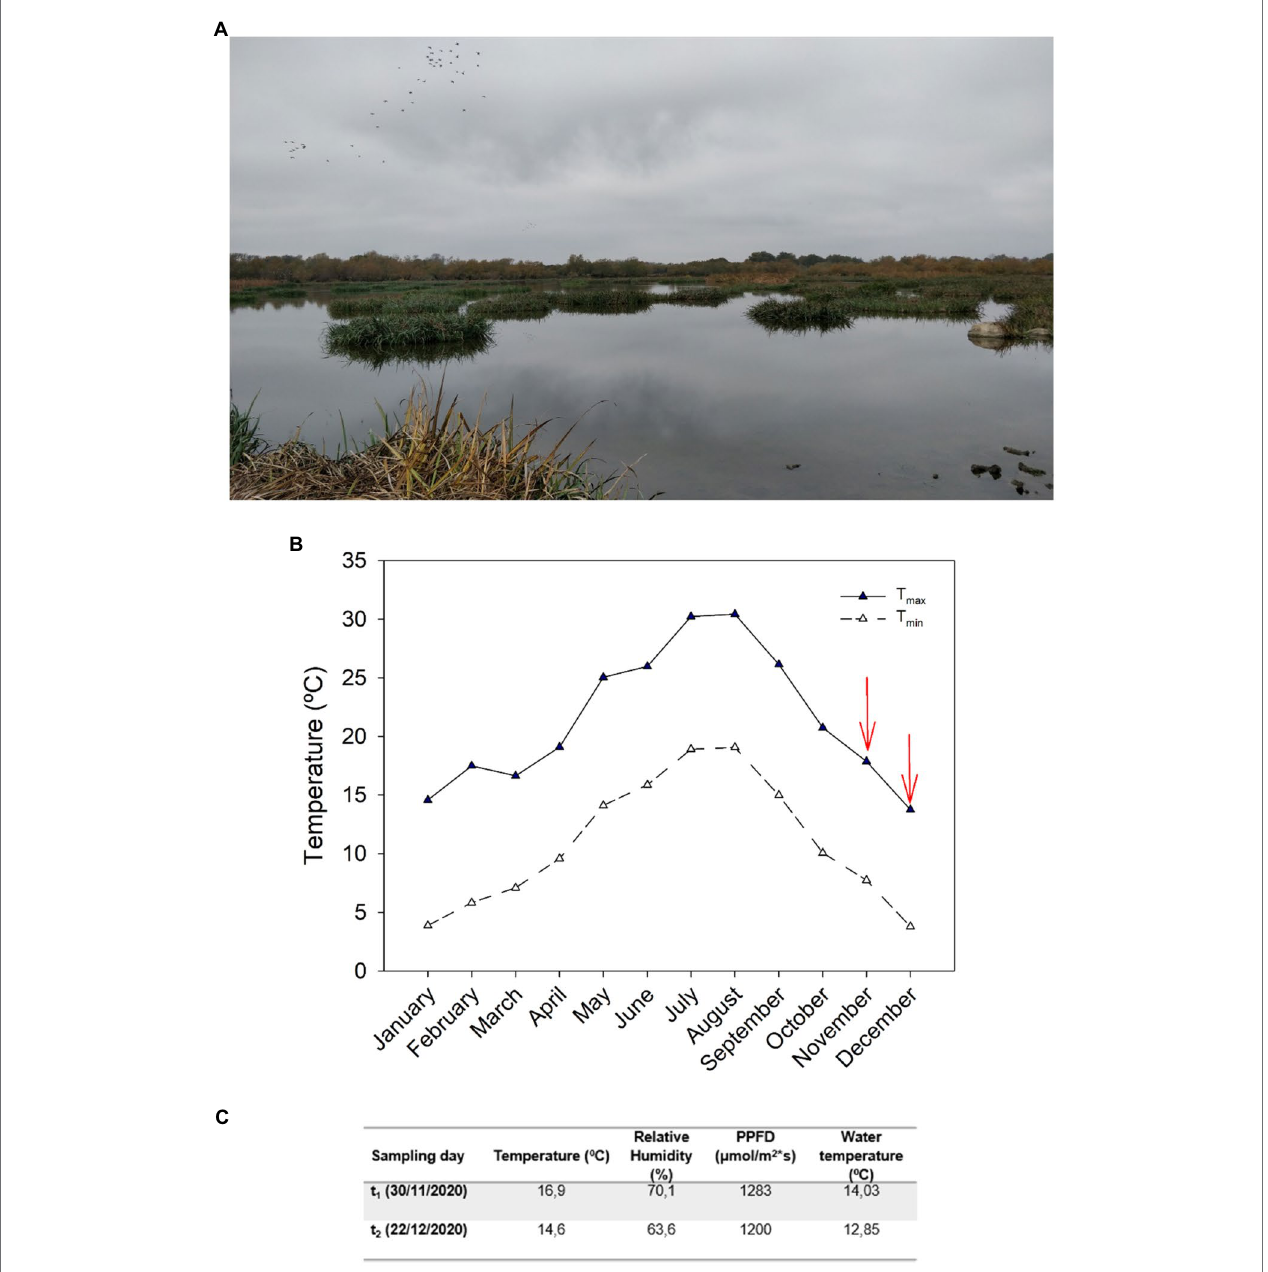
FIGURE 1 | Ecosystem description and climatological data from the study site. (A) Image taken from the study site at Estany de Vilaüt (42.283 N, 3.117E) located in the northeast of Catalonia, Spain. Iris pseudacorus mats can be seen in the water. (B) Maximum and minimum average monthly temperatures during 2020 recorded by the Servei Meteorològic de Catalunya meteorological station located closest to the study site, in Castelló d’Empúries (42.260 N, 3.074E). (C) Temperature, relative humidity (RH), photosynthetic photon flux density (PPFD), and water temperature at midday during the two sampling days (November 30 and December 22, 2020) recorded at the site of